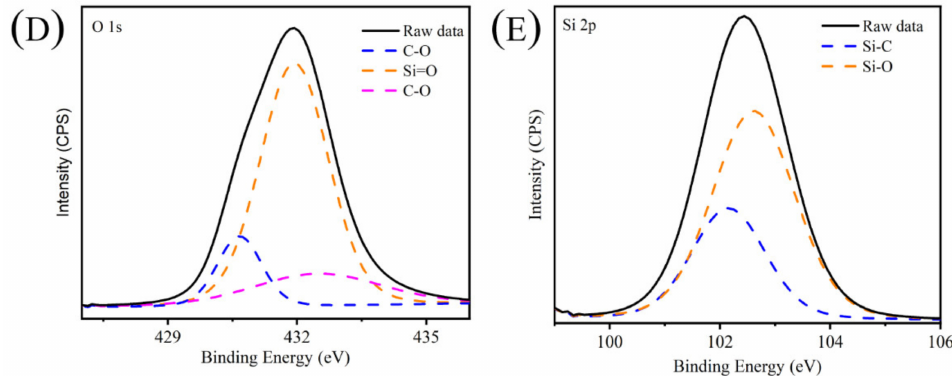
Figure 3. Survey XPS spectrum of CAP ( A ) and the high-resolution XPS peaks of C 1s ( B ), N 1s ( C ), O 1s ( D ), and Si 2p ( E ).